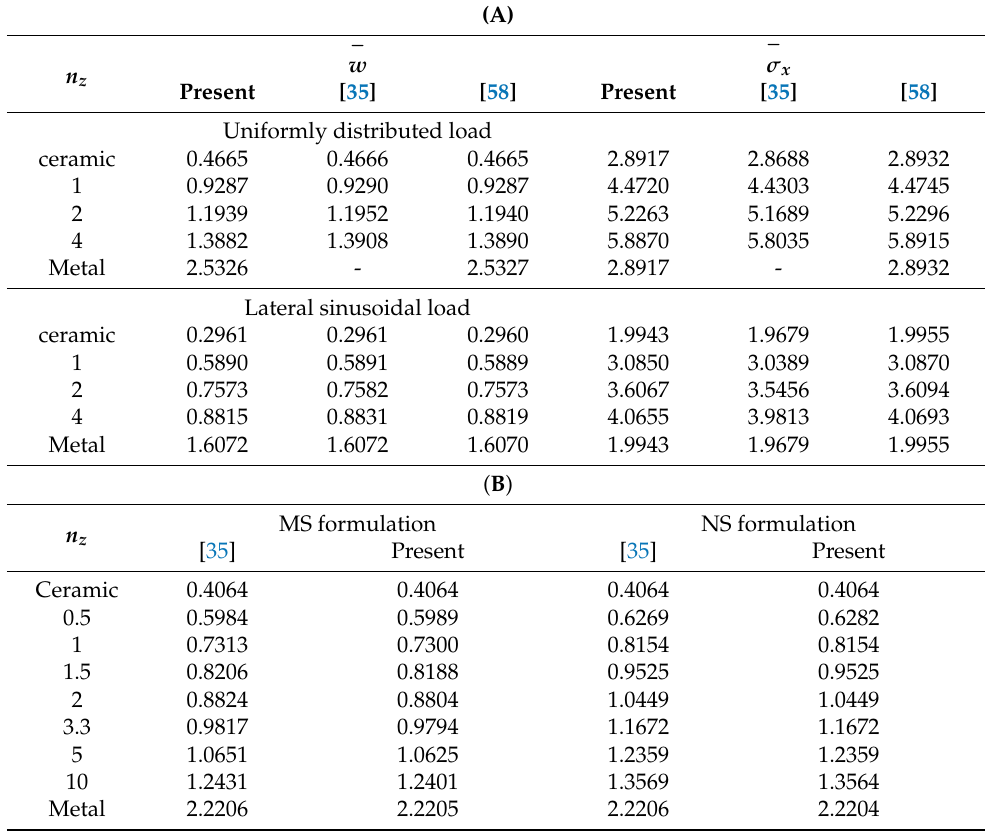
Table 1. ( A ) Comparison of the non-dimensional maximum deflection (cid:16) (cid:17) σ x = h σ x of the BDFG Al / Al 2 O 3 immovable simply supported square plate ( a / h = 10 ) un- aq 0 der uniform/sinusoidal transversal load based on neutral surface formulation ( NS ) . ( B ) Comparison with Singha et al. [37] for linear bending of immovable simply supported FG plates under